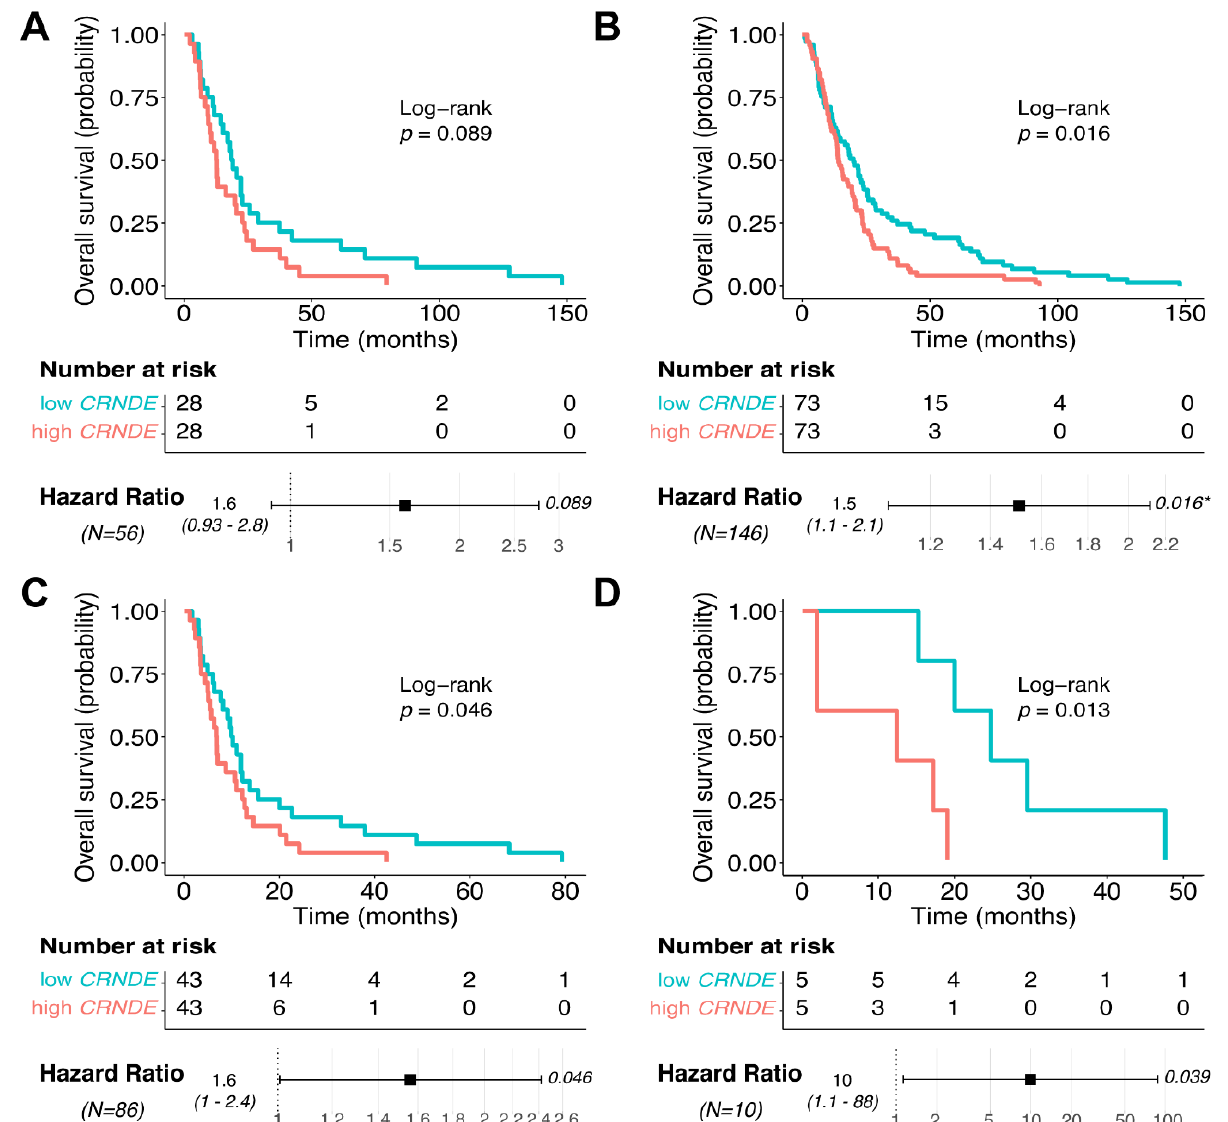
Figure 9. Kaplan–Meier plot and hazard ratio for CRNDE expression in glioblastoma samples across ( A ) CGGA_325, ( B ) CGGA_693, ( C ) TCGA and ( D ) Slovenia datasets for overall survival (OS) analysis. These results demonstrate that in there out of four tested datasets with available overall survival data (CGGA_693, TCGA, Slovenia), glioblastoma patients with overexpressed CRNDE had significantly lower overall survival ( p = 0.013-0.046).